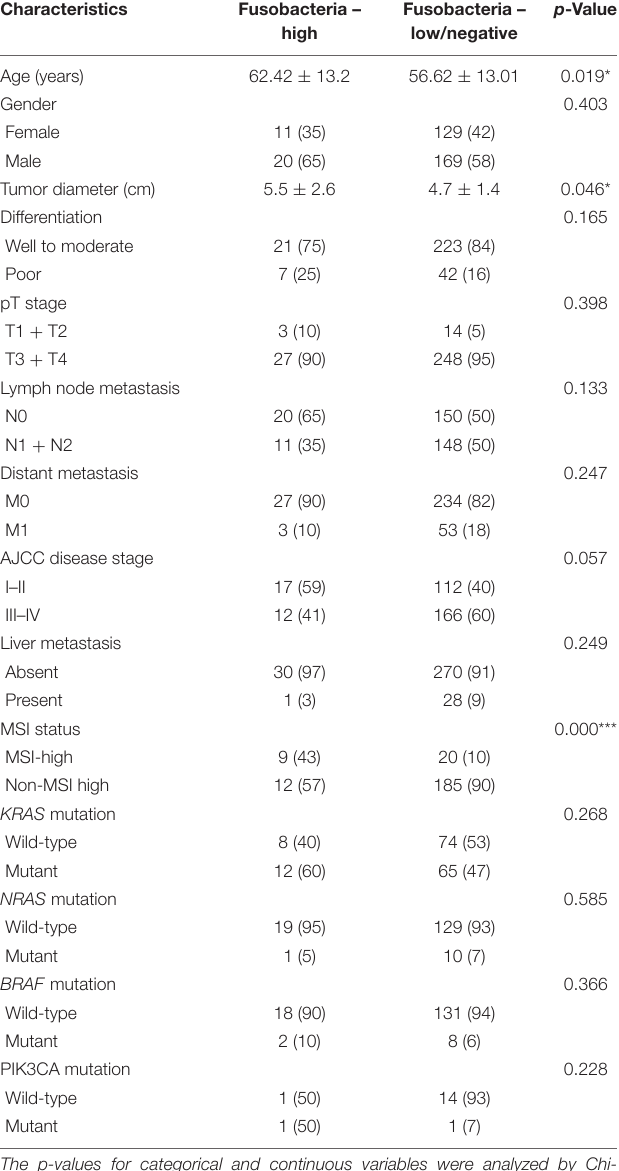
TABLE 4 | Characteristics according to the relative abundance of Fusobacteria in CRC